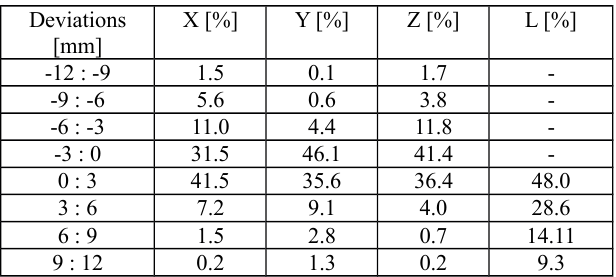
Table 2. Percentage number of points for specified deviations -